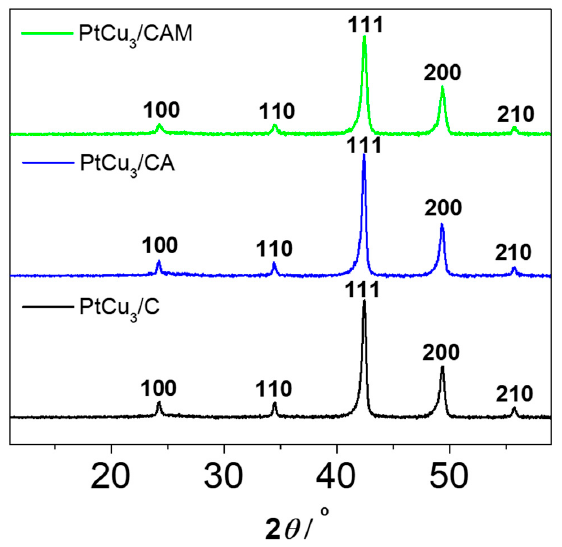
Figure 1. XRD analysis of PtCu 3 /C analogues—as-prepared (PtCu 3 /C), acid washed (PtCu 3 /CA), and acid washed + milled (PtCu 3 /CAM).